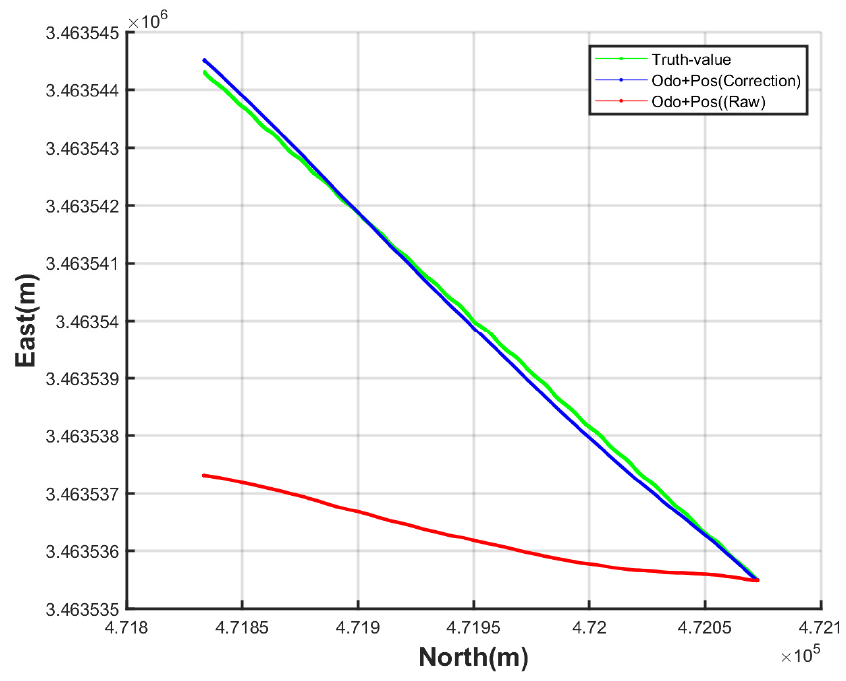
Figure 13. The influence of installation declination on the trajectory.